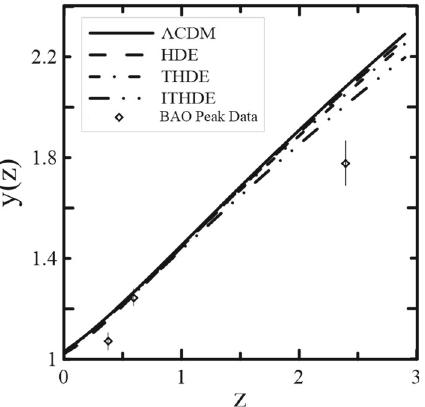
interacting and non-interacting THDE are unstable against background perturbations in early time, present and late time. Taking time derivative of Eq. (17) and using Eq. (17),